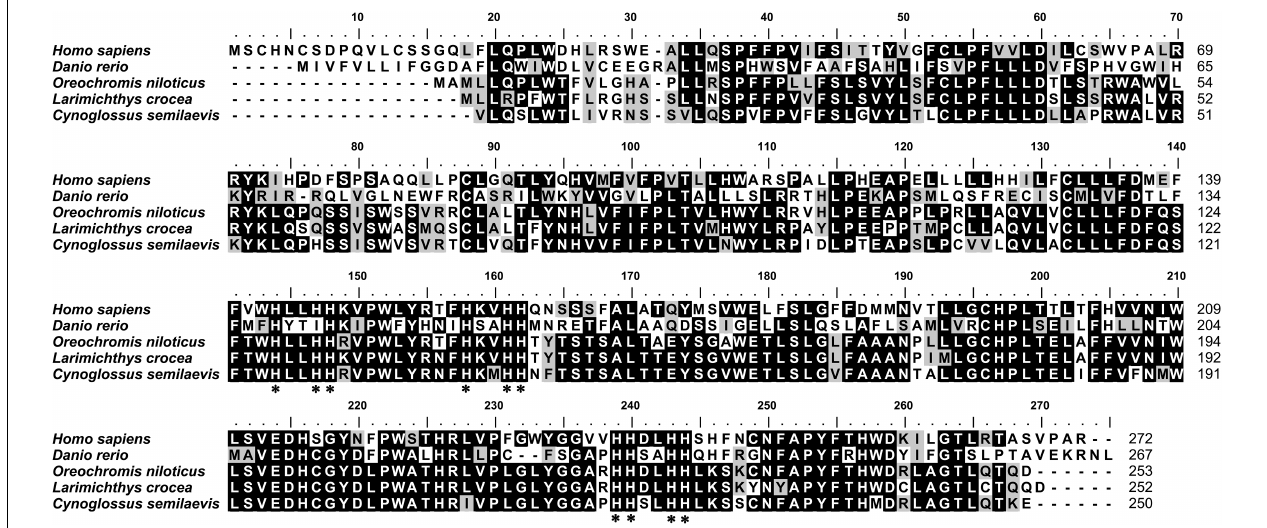
FIGURE 1 | Comparison of the deduced Ch25h amino acid sequences from Chinese tongue sole, other fish, and human. The amino acid sequences were aligned using ClustalX. Identical residues are shaded black and similar residues are shaded gray. Gaps (-) were introduced to maximize the alignment. Asterisk indicates conserved clusters of histidine